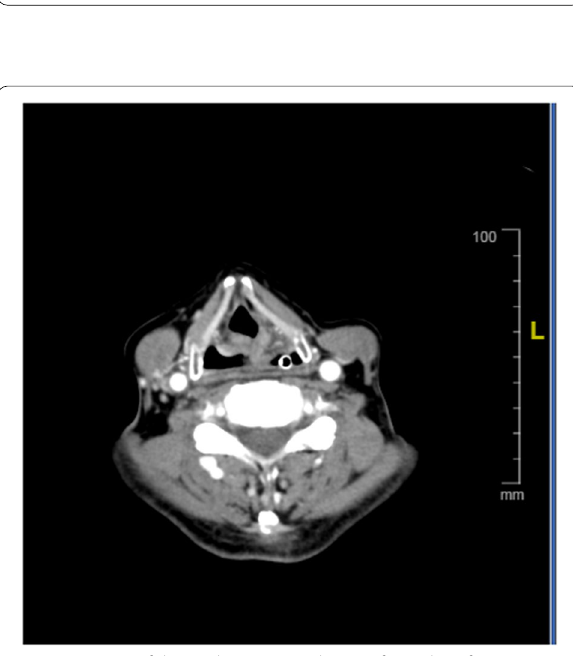
Fig. 4 CT scan of the neck. Post completion of 6 cycles of chemotherapy showed a resolution of hypopharyngeal